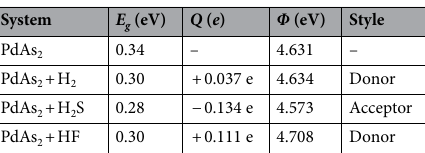
Table 2. The electronic band gap ( E g ), charge transfer ( Q ), work function ( Φ ) and